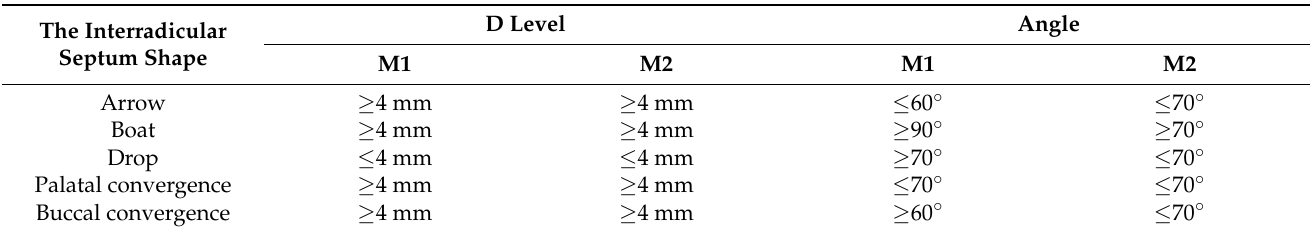
Table 1. The quantitative criteria for maxillary molars’ IRS shape classification obtained in the coronal (D level and IR furcation angle) CBCT view.